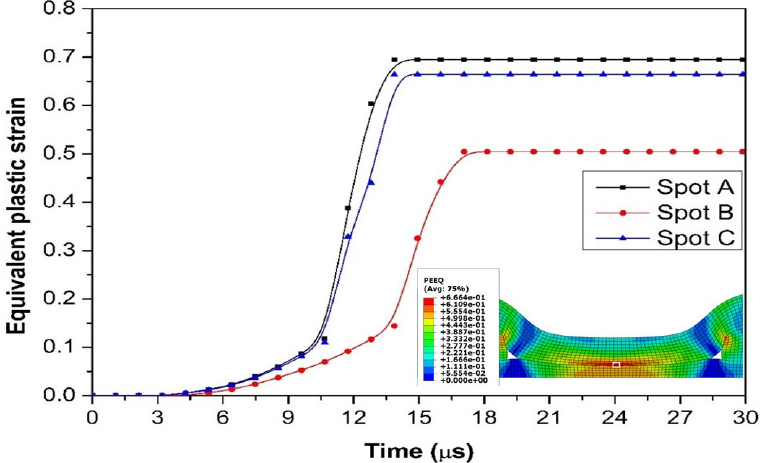
Figure 19. Equivalent plastic strain graph of the three spots. Window image shows the variations for spot C.